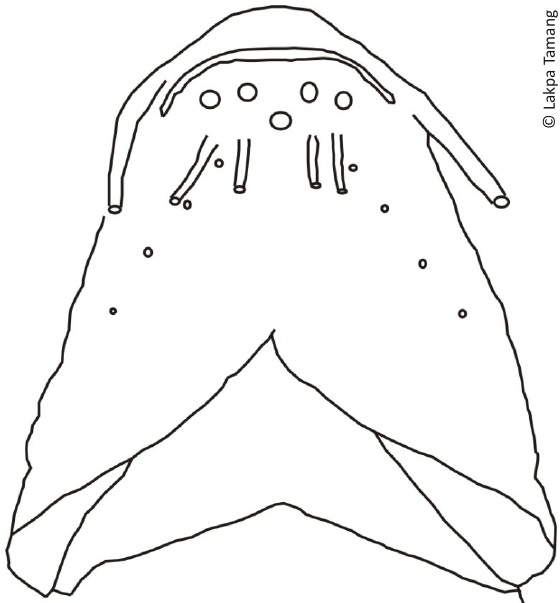
Figure 1. Schematic diagram of mental region of B. merianiensis showing the sensory pores.